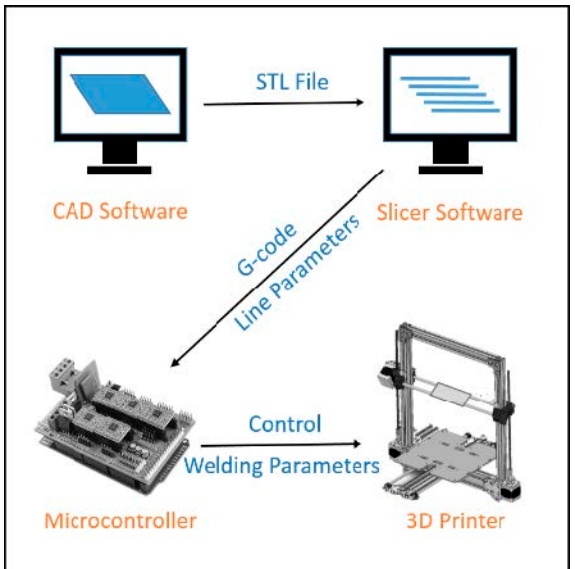
Figure 3. The process of 3D printing an object from a 3D CAD model.